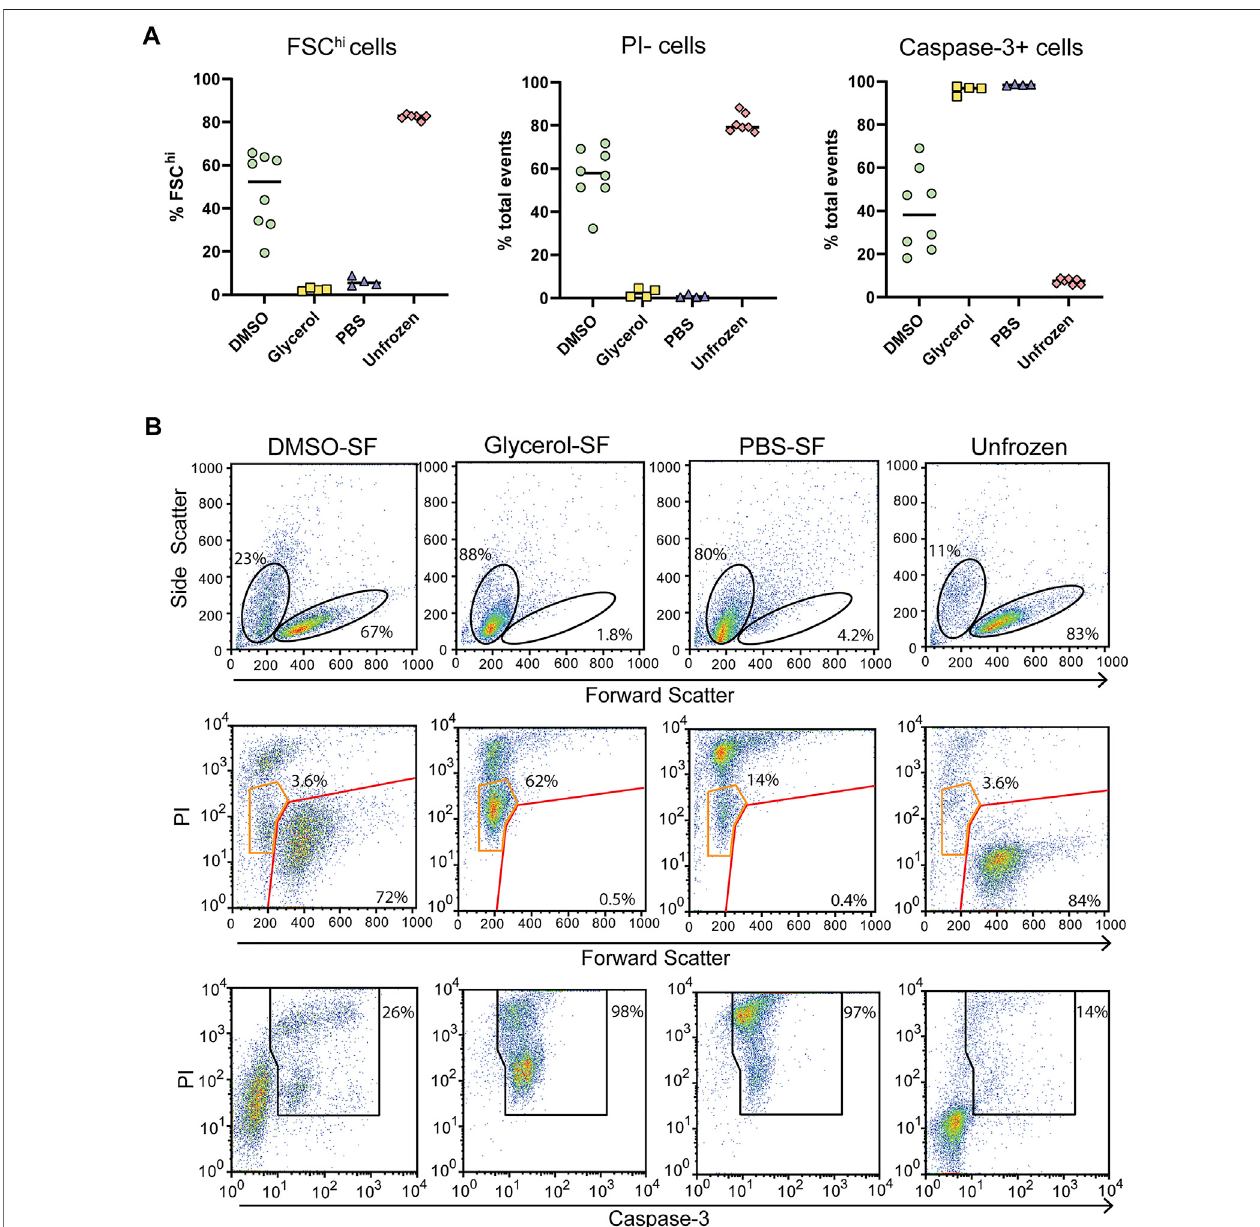
FIGURE 5 | Post thaw cellular integrity and apoptosis induction with slow-freezing (SF). (A) Quanti fi cation of cell viability by fl ow cytometry through FSC fl uorescence, PI, and caspase-3 staining. Each symbol represents a single sample/rotor. (B) Representative fl ow cytometry plots show the gating strategy used to determine the percentages in (A). All plots show total events. Top panels show the gating strategy used to determine FSC hi cells. Middle panels show PIuptakeofFSC hi cells (red gate) and FSC lo cells (orange gate) cells. Bottom panels show the gating strategy used to determine caspase-3+ cells.